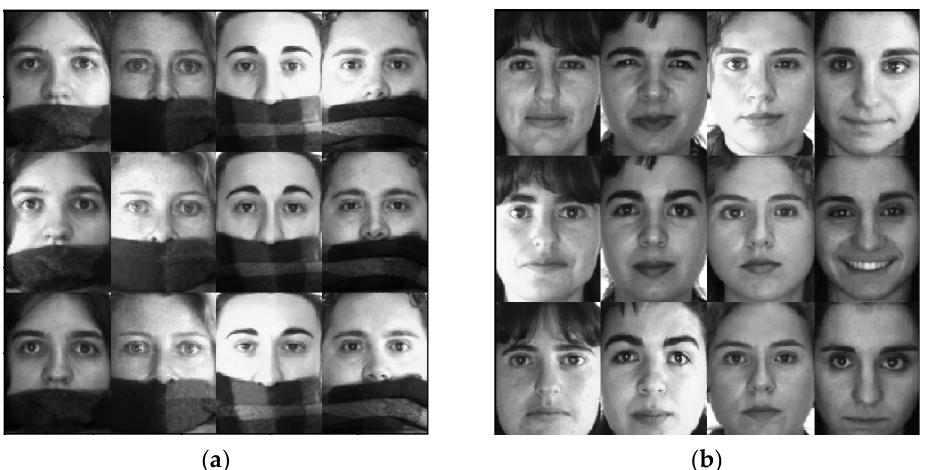
Figure 10. Some face images from the AR subset: ( a ) the left picture shows some of the training images used in the experiment; ( b ) the right picture shows some of the test samples used in the experiment [ Reprinted with permission from Elsevier [20]. Copyright 2013, Neurocomputing ] . Table 3. Accuracy of different methods when recognizing face images with scarves (images are downsampled to 500 dimensions).